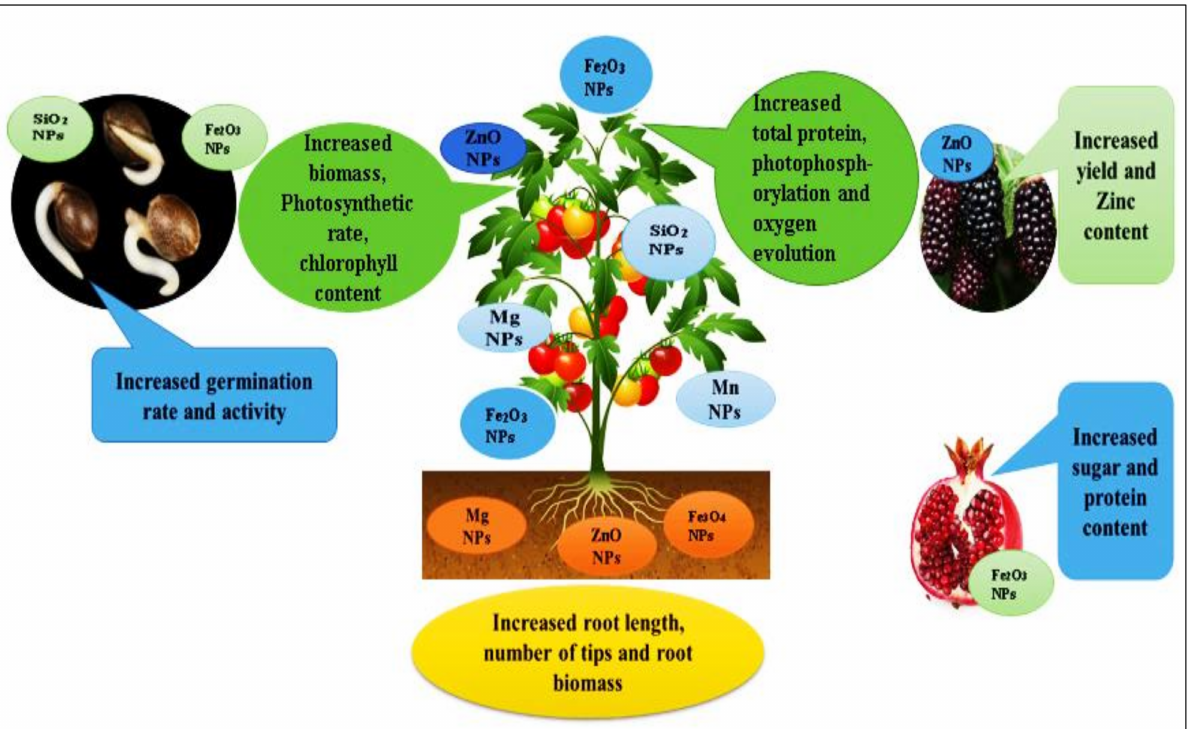
Figure 2. Schematic overview of improvements of germination of seeds, growth of plants, and production of higher biomass or yield by the application of various kinds of nano-fertilizers (adapted and redrawn from Zhao et al.